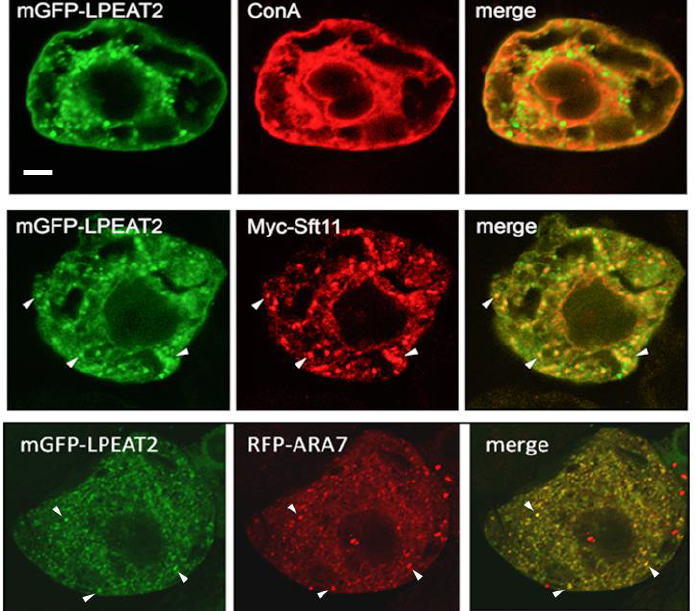
Figure 2. Subcellular localization of Arabidopsis LPEAT2 in BY-2 cells transiently-(co)transformed via biolistic bombardment with (as indicated by labels) mGFP-LPEAT2 (green) and the Golgi marker Myc-Sft11 (red) or the late endosomal marker RFP-ARA7 (red), or stained with fluorescent dye-conjugated ConA (red), serving as an ER stain. Shown are representative images, as well as the corresponding merged images for each set of (co)transformed cells. The yellow color in the merged images indicates co-localization of two proteins (also shown by arrowheads). Scale bar, 10 μ m.